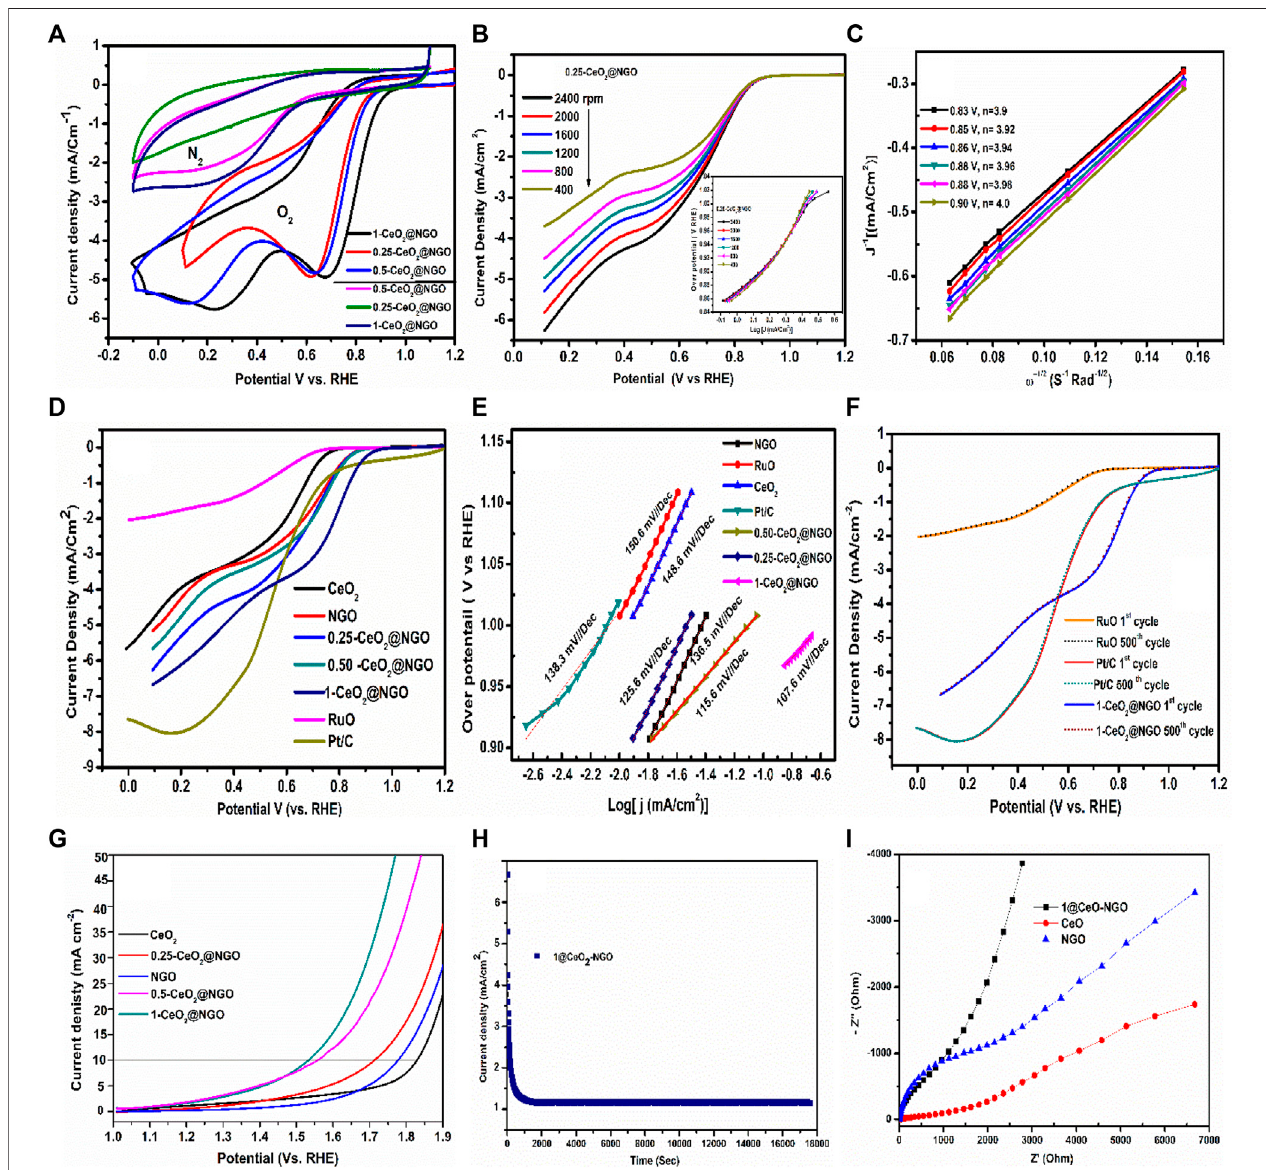
FIGURE 4 | (A) CV in oxygen and nitrogen-saturated conditions, CV in 0.5 M KOH, scanning rate 100 mVS − 1 for NGO, 0.25@CeO 2 -NGO, 1@CeO 2 -NGO, and RuO 2 . (B) LSV graph of 0.25@CeO2-NGO with different rpm values at 5 mVS − 1 (inset image Tafel slope for 0.25@CeO 2- NGO). (C) K-L plot for 0.25@CeO2-NGO. (D)